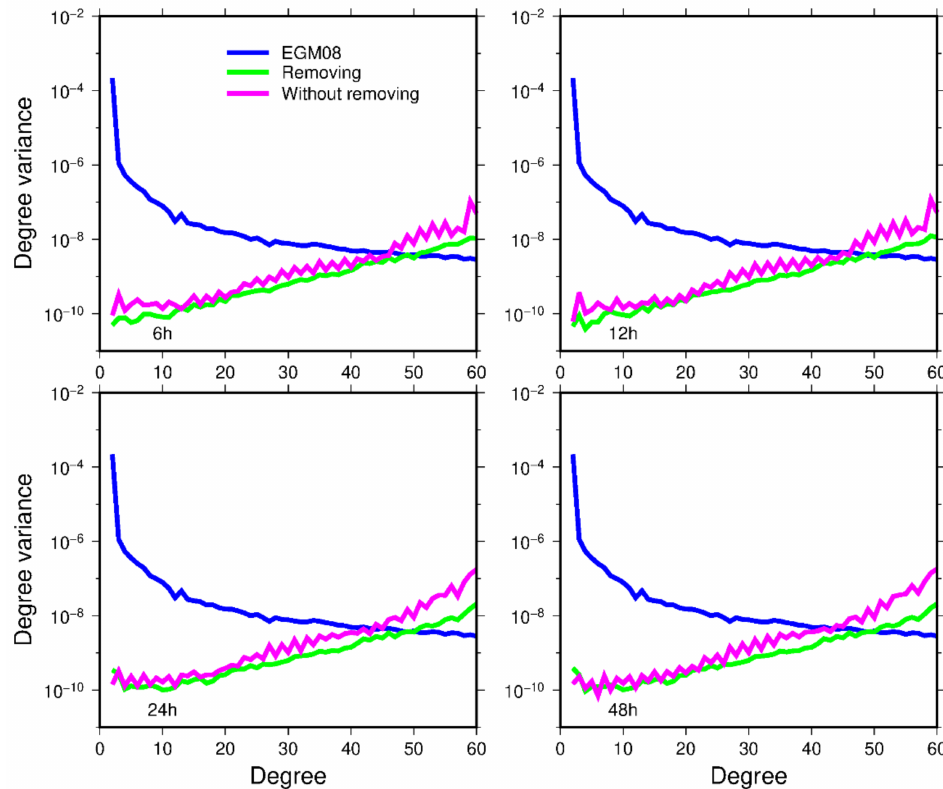
Figure 1. The degree variance of the recovered gravity field by using 6, 12, 24, and 48 h arcs, when using orbit data to recover gravity field.